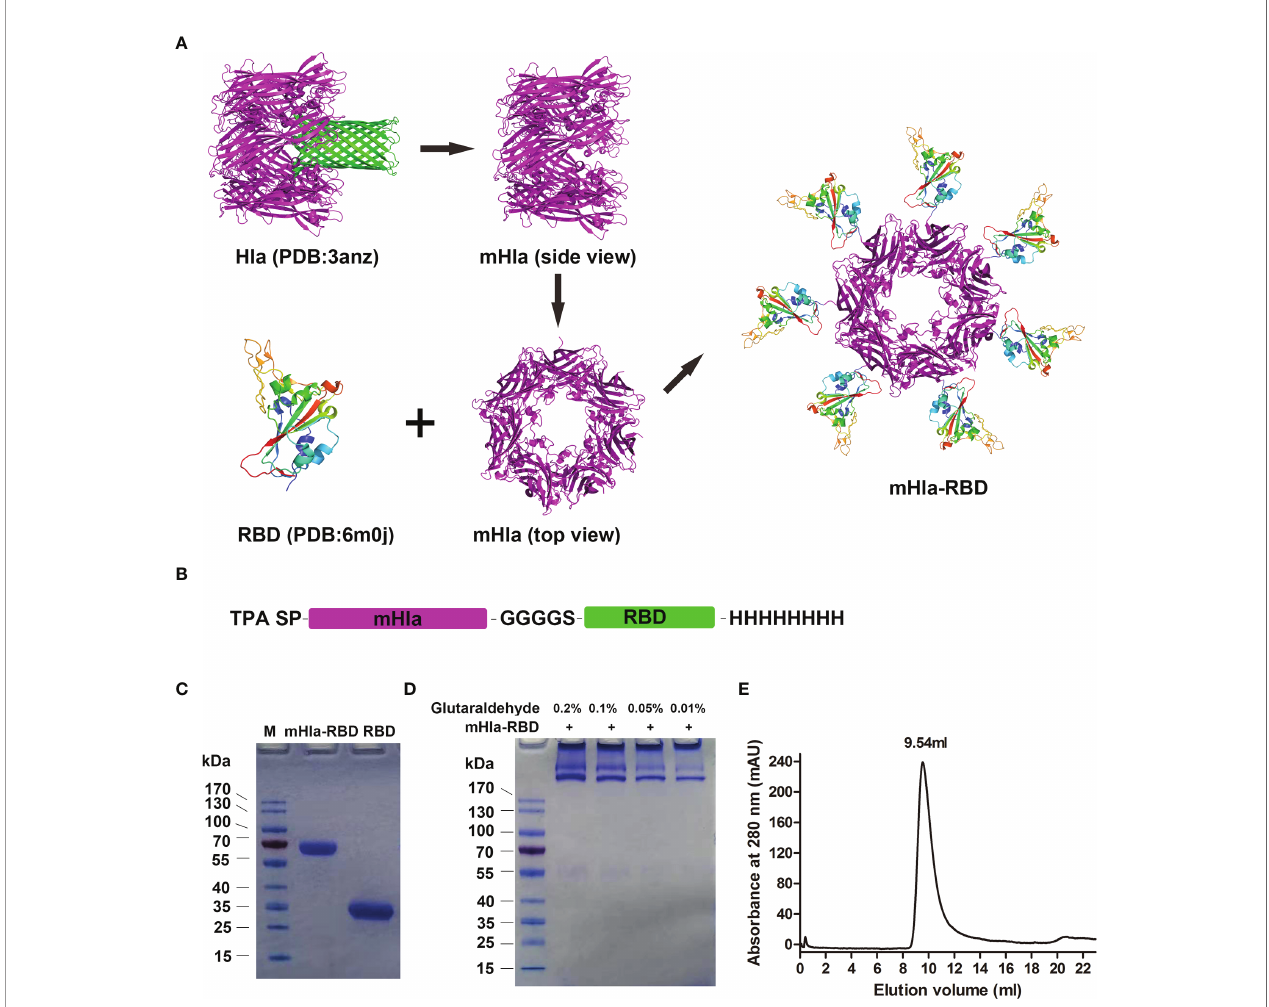
FIGURE 1 | Design, preparation, and characterization of mHla-RBD. (A) The schematic diagram of RBD heptamer design. mHla, which lucks the transmembrane b - barrel structure, was used as the carrier protein, and RBD was located on the surface of mHla. (B) The designation of the fusion protein. (C) SDS-PAGE analysis of puri fi ed RBD and mHla-RBD. (D) SDS-PAGE analysis of mHla-RBD after treatment with 0.01%, 0.05%, 0.1%, and 0.2% glutaraldehyde. (E) Oligomeric state of mHla-RBD determined by size-elution